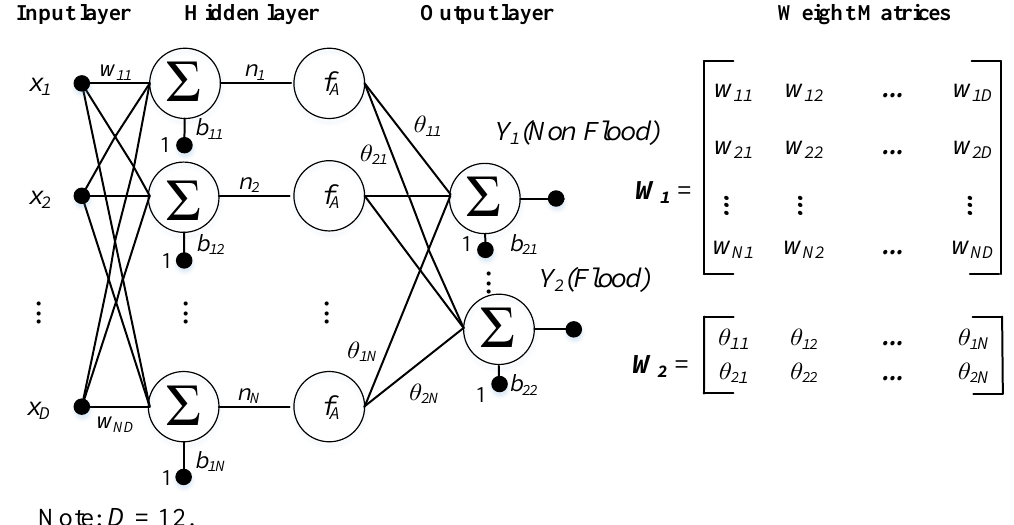
Figure 3. The structure of an ANN model used for spatial prediction of flash flood.